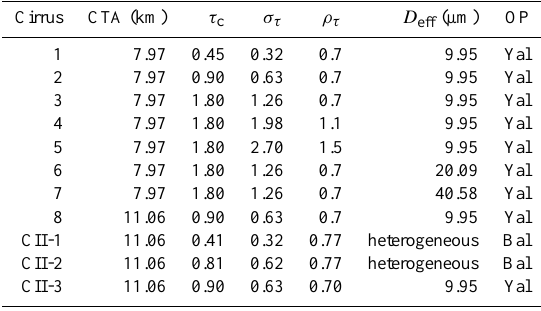
Table 1. Mean cloud properties of the cirrus generated by 3DCLOUD. “CTA” corresponds to the cirrus-top altitude; “OP” corresponds to the optical properties parametrization; “Yal” repre- sents the model of ice crystals developed by Yang et al. (2001, 2005) for aggregates ice crystals; and “Bal” represents the parametrization of ice crystals’ optical properties developed by Baran et al. (2009), Baran (2012), and Baran et al. (2013); τ c is the cloud mean optical thickness; σ τ is the cloud standard deviation of the optical thickness estimated from the optical thickness of the subpixels at the scale of 100m × 100m; ρ τ is the cloud heterogeneity parameter defined as the ratio of σ τ by τ c ; and D eff is the ice crystal effective diameter. Cirrus CTA (km) τ c σ τ ρ τ D eff (µm)